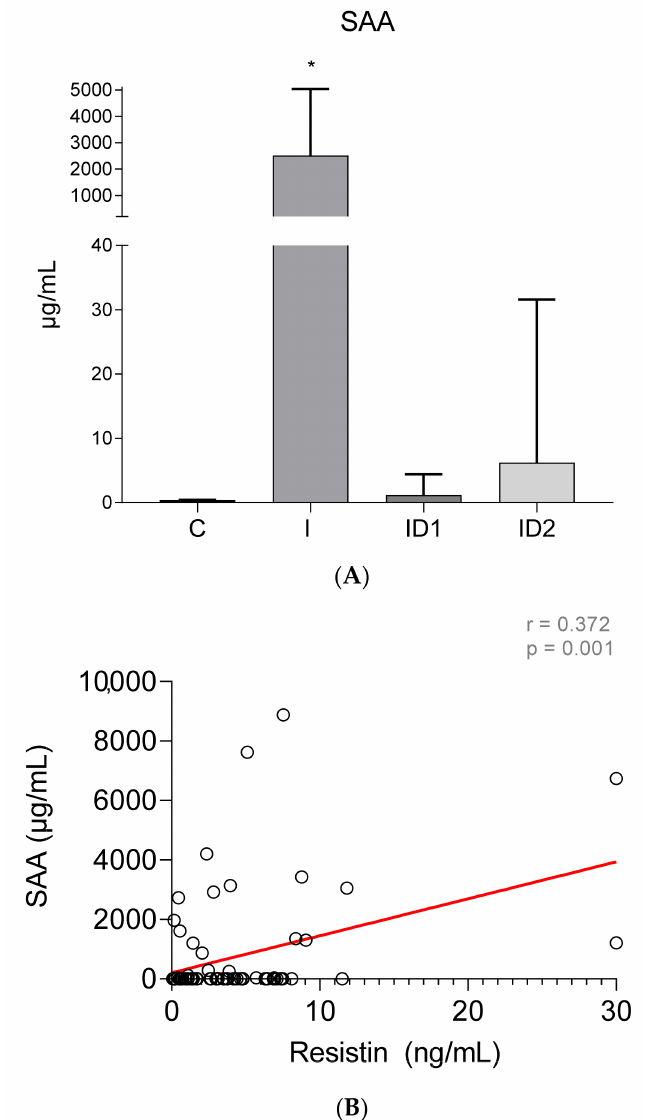
Figure 4. ( A ) Plasma serum amyloid A concentration( µ g/mL) in the different groups. Control group (C) n = 14, inflammatory group (I) n = 21, mild insulin dysregulation group (ID1) n = 18, severe insulin dysregulation group (ID2) n = 19. Bars represent mean + SD. Asterisks indicate significant differences with the control group (* p < 0.05). ( B ) Correlation between the plasma SAA concentration ( µ g/mL) and plasma resistin concentration (ng/mL) in 72 horses. The linear regression line is draw red solid (n = 72, r = 0.372, p = 0.001). Plasma iron concentrations were significantly decreased in the inflammatory group, 94.51 ± 45.58 µ mol/dL ( p < 0.001), and to a lesser extent in both insulin dysregulation groups, 137.51 ± 62.62 (ID1) ( p = 0.018) and 143.19 ± 57.79 (ID2) µ mol/dL ( p = 0.032), when compared with control horses, 191.50 ± 86.46 µ mol/dL (Figure 5A). No significant correlation was found between plasma iron concentrations and plasma resistin levels (r = − 0.174; p = 0.143) (Figure